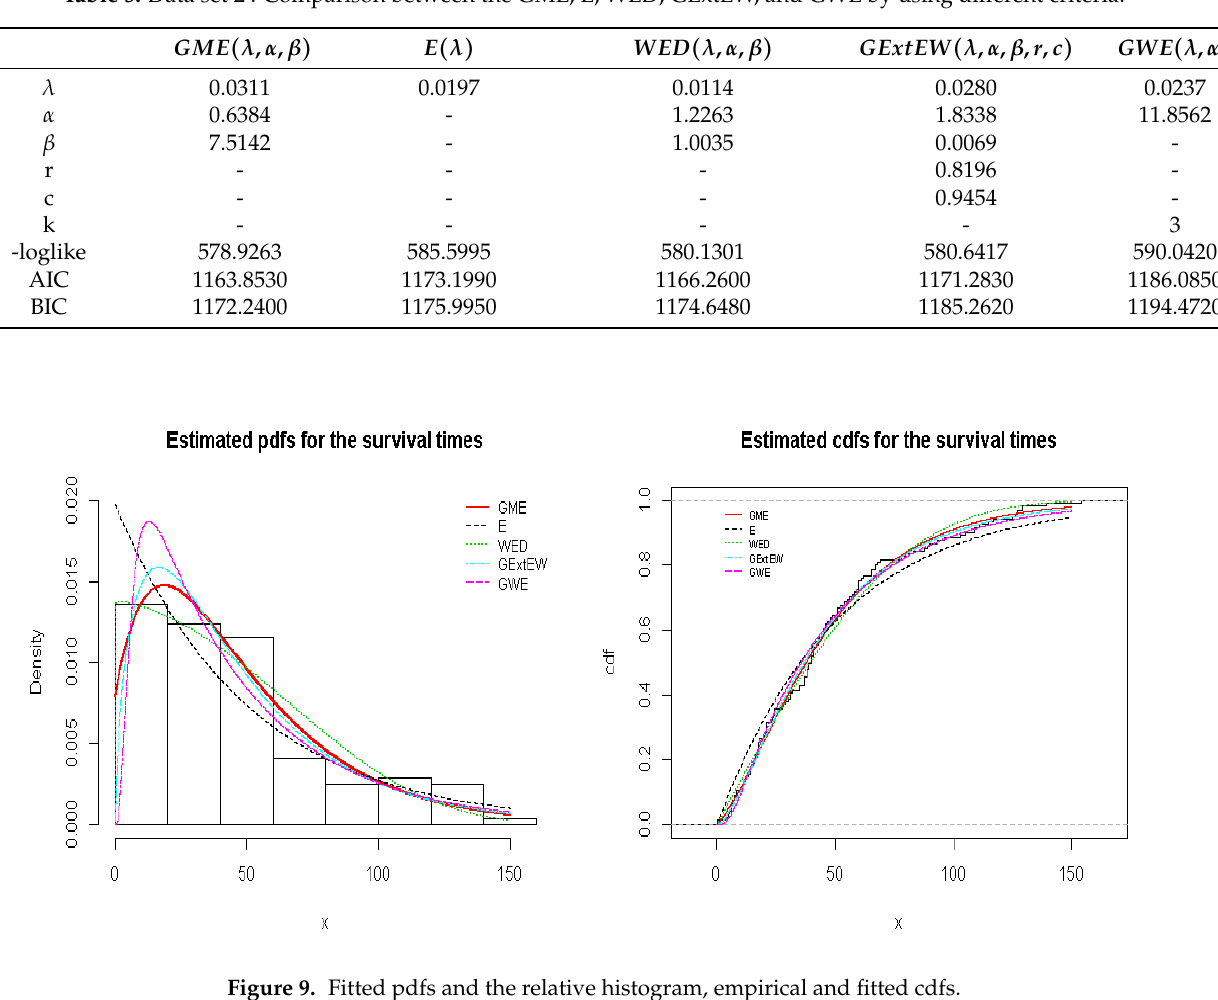
Table 5. Data set 2 : Comparison between the GME, E, WED, GExtEW, and GWE by using different criteria.